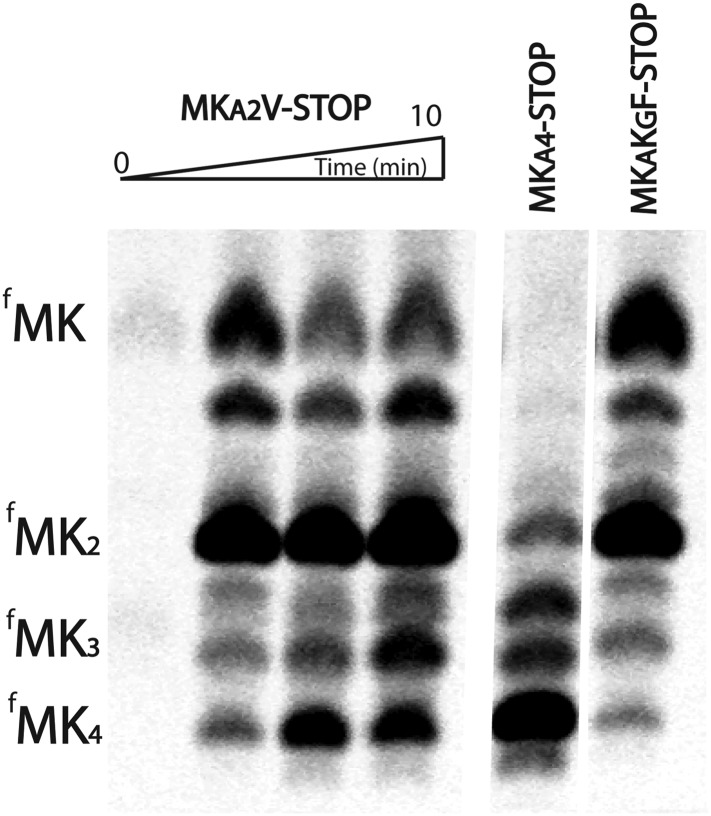
E. coli ribosomes add extra lysines to peptides translated on messages containing sequential AAA-AAG lysine codons.TLC showing all of the peptide products resulting from translation of MKA2V-Stop, MKA3-Stop, MKA4-STOP, and MKAKGF-Stop messages with Lys-tRNAlys (but no other tRNAs or release factors) present.